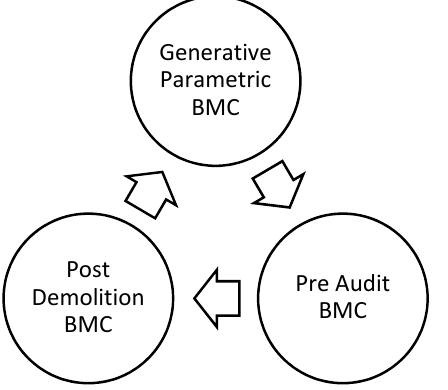
Figure 4. BMC synergies to improve reliability in material prediction between the post demolition BMC and future predictions of BMC.